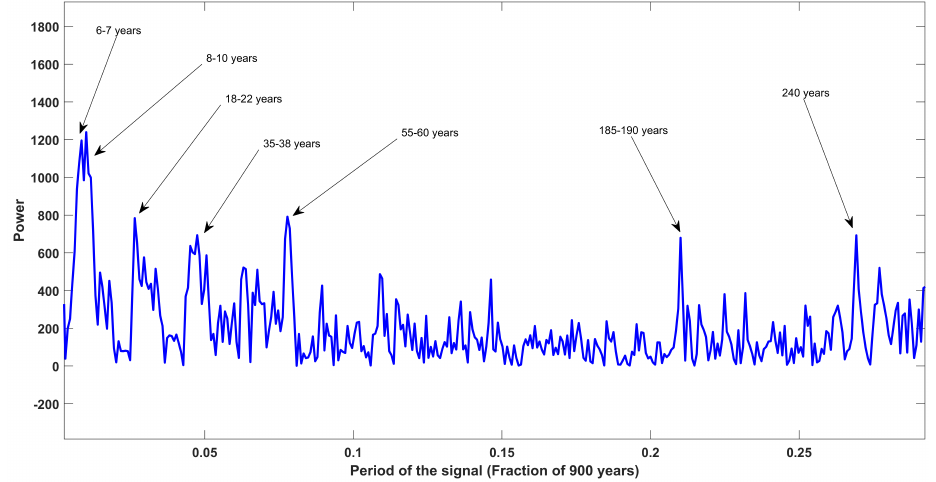
Figure 6. Power spectrum of European seismicity (M > 5.0, 1106–2006, SHEEC catalogue). Tidal periodicities are detected in the recurrence times of intense seismicity in Europe. nuFFT is used for the calculation to take into account progressive decrease of completeness